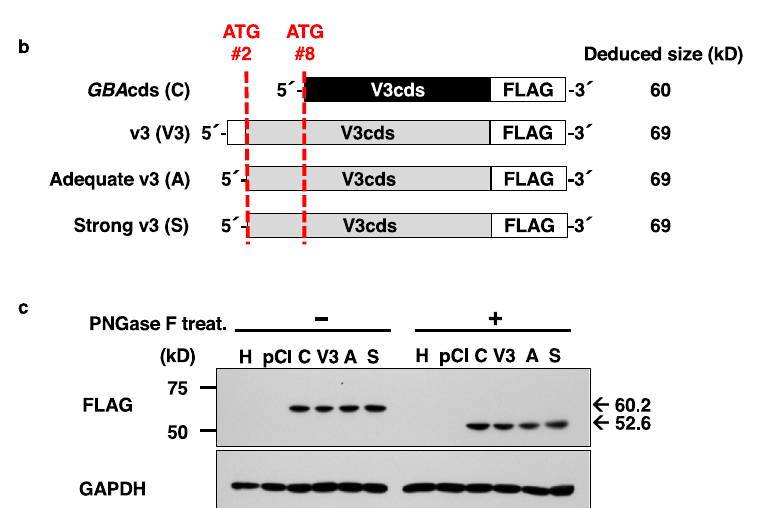
Fig. 5 Upstream ATG, uORF, and Kozak sequences. a Positions of uATGs, uORFs, and their Kozak sequences within the region from exon 1 to exon 5. The ATGs are numbered from the 5 ’ ends of the P1 promoter-controlled transcripts. Two reported start sites (#8 and #10) are indicated in red, and the columns are highlighted in yellow 9,20 . The numbers in the table are the predicted sizes of the ORFs for the indicated ATGs on the top line. b Schematic of three kinds of v3 constructs inserted into expression vectors. FLAG tags were added to all constructs at the 3 ’ end. Top line, CDS only; second line (C), CDS with the original 5 ’ UTR containing a weak Kozak sequence (V3); third line, CDS with a partial 5 ’ UTR containing an adequate Kozak sequence (A); fourth line, CDS with a partial 5 ’ UTR containing a strong Kozak sequence (S). c FLAG-tagged GCase expression with or without glycosylation in HEK293 cells. GCase protein expression was detected by western blot analysis with anti-FLAG antibodies. C, V3, A, and S indicate the same as in b . pCI, empty vector; H, HEK293 cells without transfection. The molecular sizes are indicated on the right side. The experiment was performed in triplicate and the representative data was